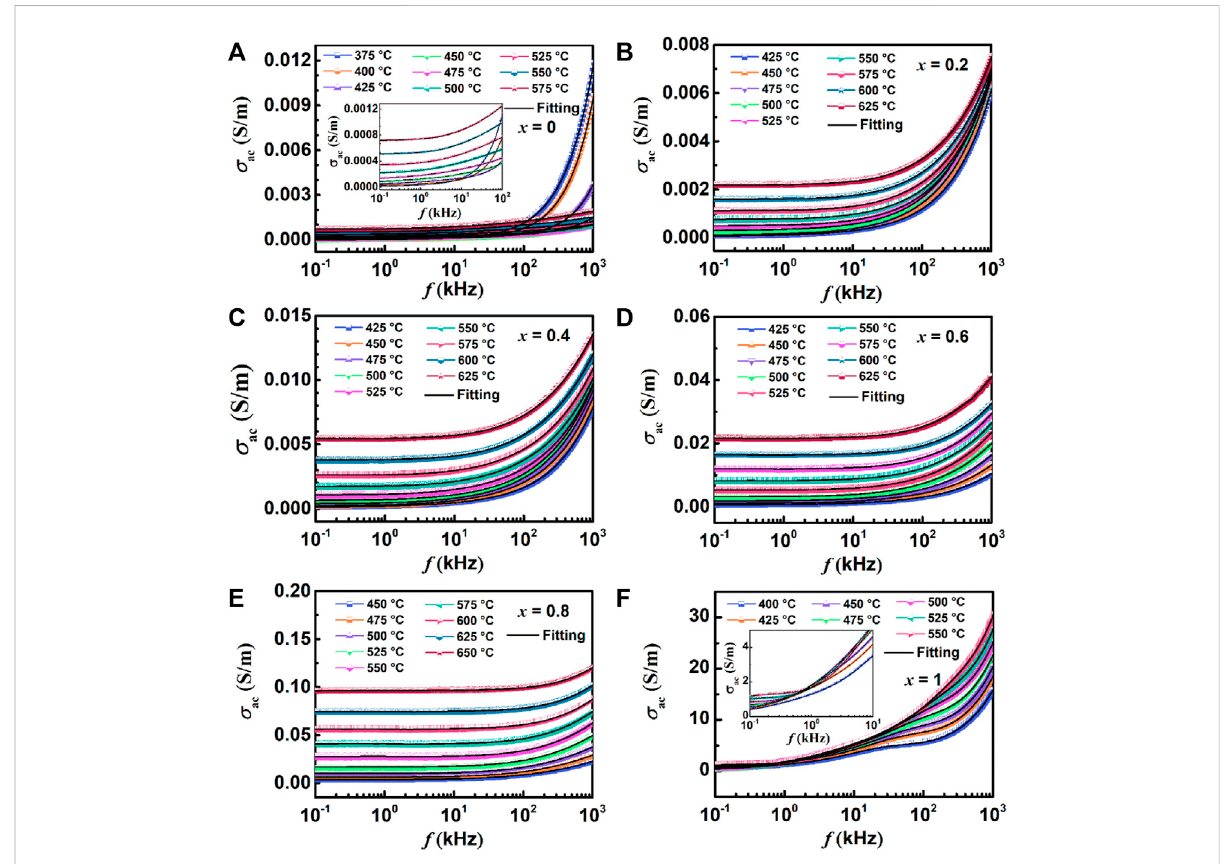
FIGURE 11 Variation of AC conductivity and frequency at different temperatures: (A) BBT, (B) 0.8BBT-0.2BiT, (C) 0.6BBT-0.4BiT, (D) 0.4BBT-0.6BiT, (E) 0.2BBT-0.8BiT, and (F)